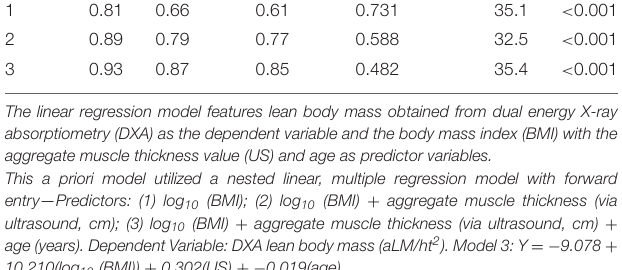
Frontiers in Physiology |